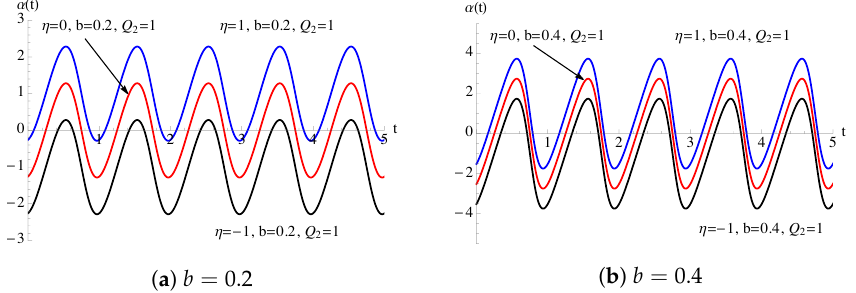
Figure 6. The growth intensity function α ( t ) , given in (54), is plotted as function of t for some choices of the